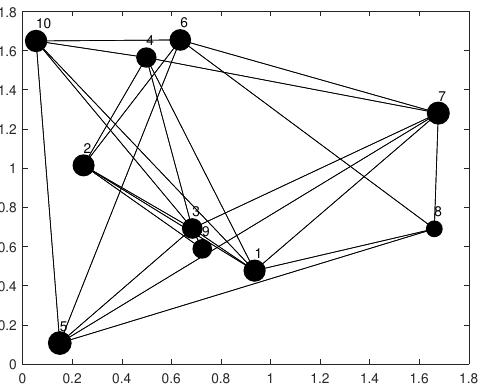
Figure 2. Spatial location of zones in a hypothetical instance 1, where 1 to 10 are the geographical • zones, with sketching a discrete center whose diameter is proportional to the demand for healthcare centers in the indicated